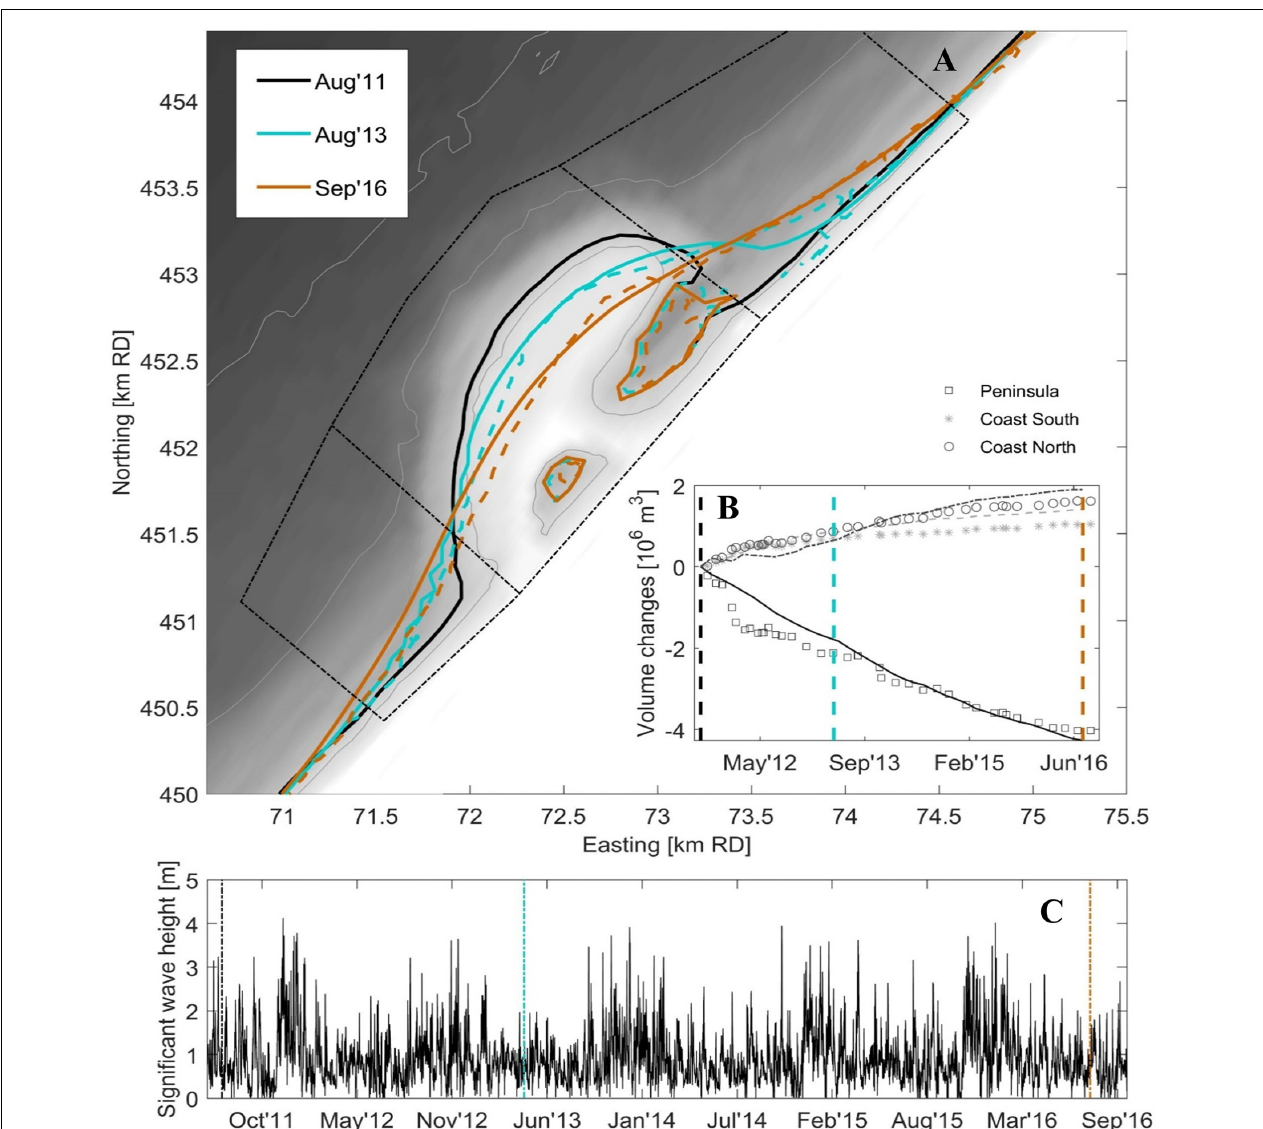
FIGURE 11 | (A) Observed and simulated evolution of the Sand Engine using ShorelineS; Color-coded lines are coastlines extracted from repeat topo-bathymetry surveys (drawn lines) and from calculations (dashed lines) for 2011 (initial), 2013 and 2016. (B) Observed and computed volume change for the areas indicated by the black dash-dot lines. (C) Time series of actual significant wave